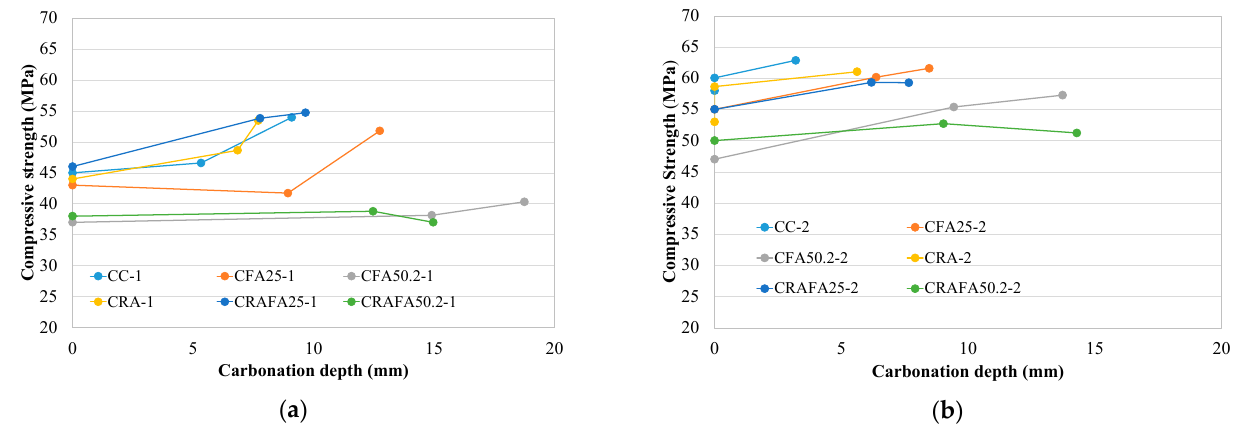
Figure 7. ( a ) Carbonation depth versus compressive strength for the carbonated samples in Series 1. ( b ) Carbonation depth versus compressive strength for the carbonated samples in Series 2.